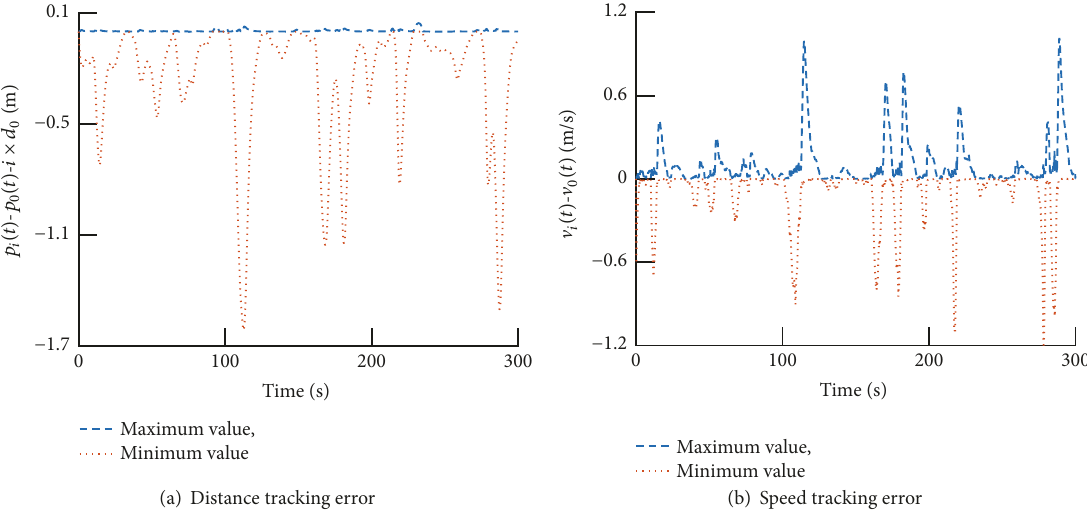
Figure 11: Simulation results of nonrobust